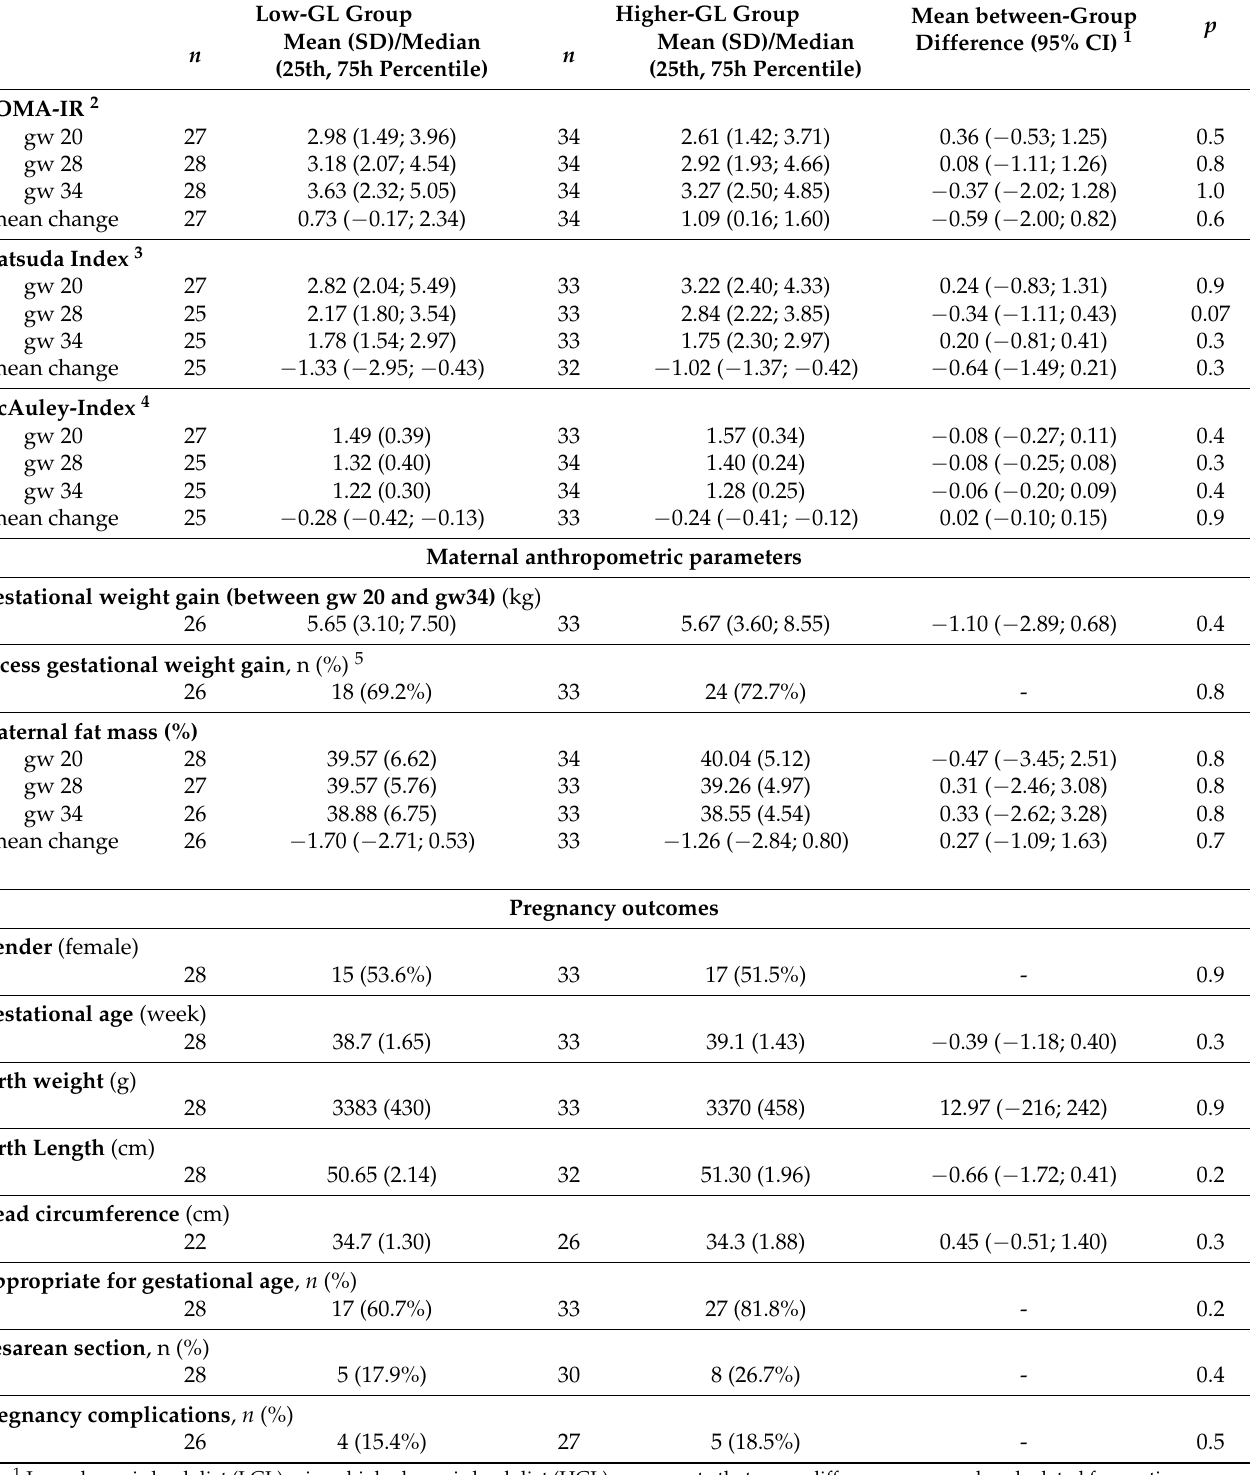
guidelines: recommended upper range of weight gain in the second and third trimester: 0.6 lb/week/0.272 kg/week [27]. Abbreviations: CI, confidence interval; iAUC, incremental area under the